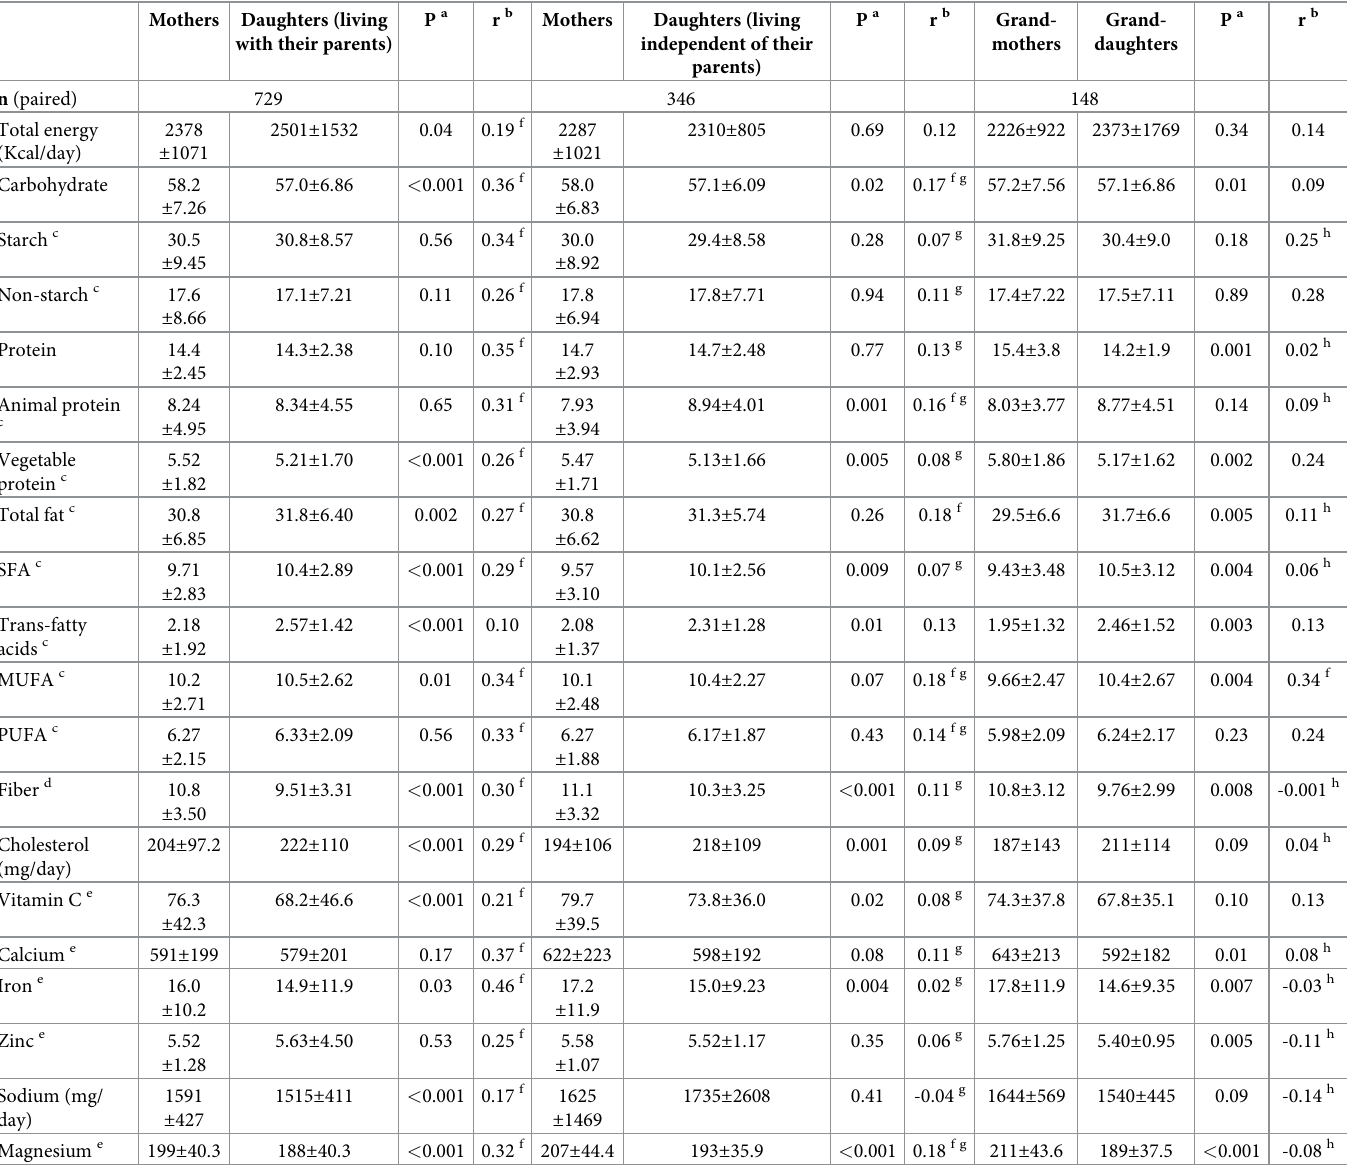
Table 5. Total energy and nutrient intakes of 3 generations of participants (Mothers-daughters) by living status. Mothers Daughters (living P a r b Mothers with their parents)